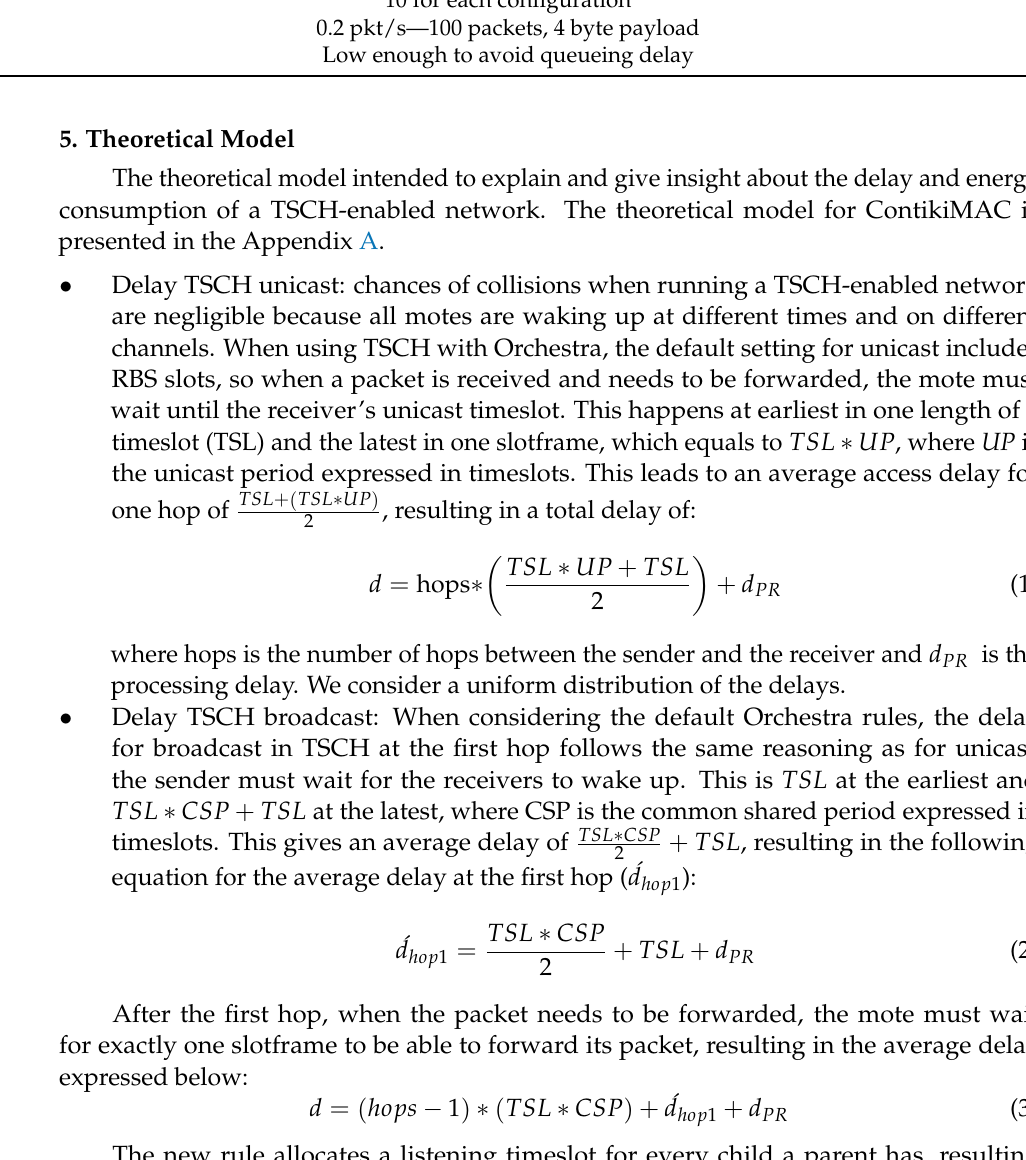
Figure 4c: 13 nodes